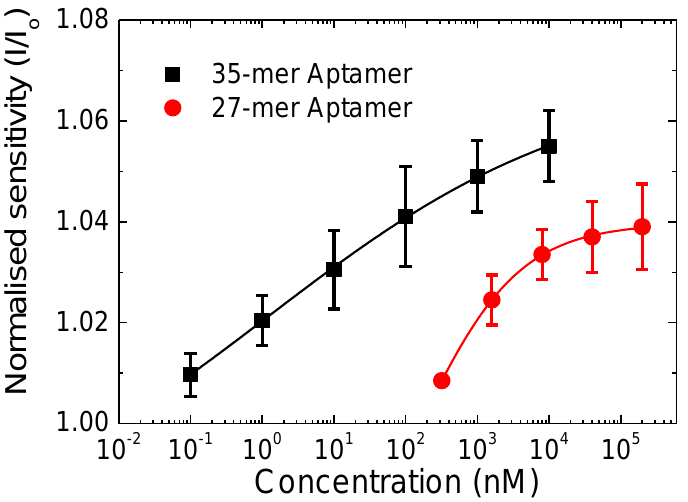
Figure 4. Normalised sensitivity in response to the added adenosine concentration for the 27-mer (circle) and 35-mer adenosine aptamer (square) immobilised CNT-FETs aptasensors. The lines indicate the corresponding Hill-Langmuir fittings of the sensing response.